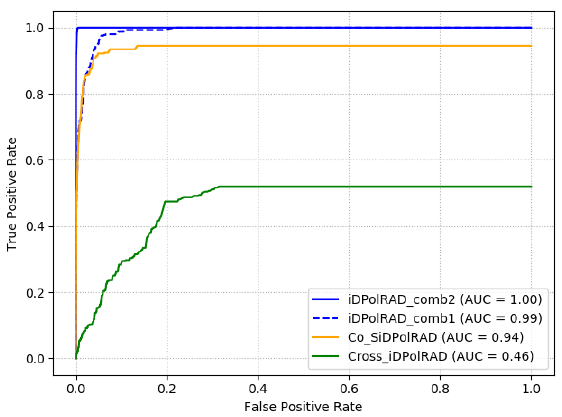
Figure 12. ROC curves for the iDPolRAD volume detector (green), its “ surface ” variant (orange) and the two new combinations in dark blue (pixel-based, multilooked).